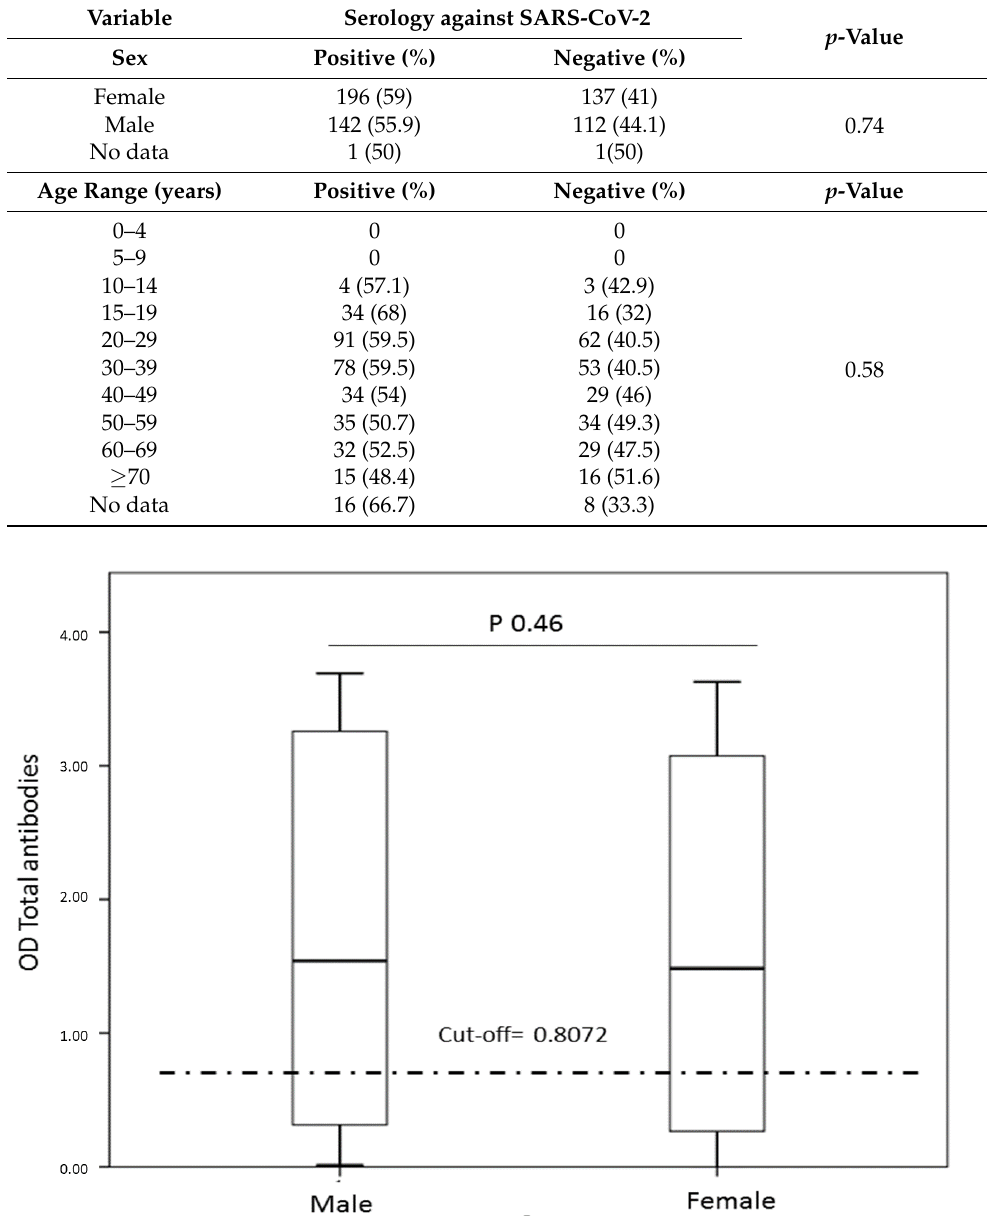
Table 2. Relationship between seropositivity against SARS-CoV-2 versus sex and age ranges in years. Variable